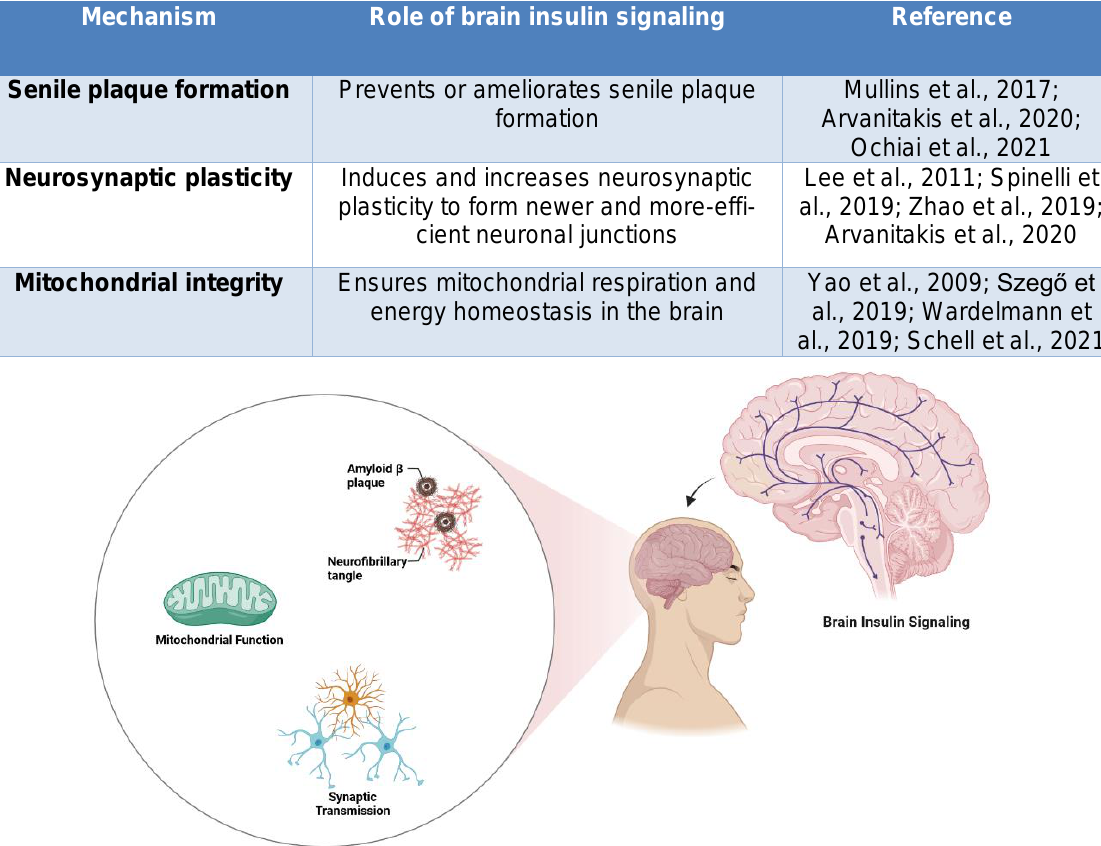
Table 1: Brain insulin signaling modulates cognitive ability via 3 distinct mechanisms.